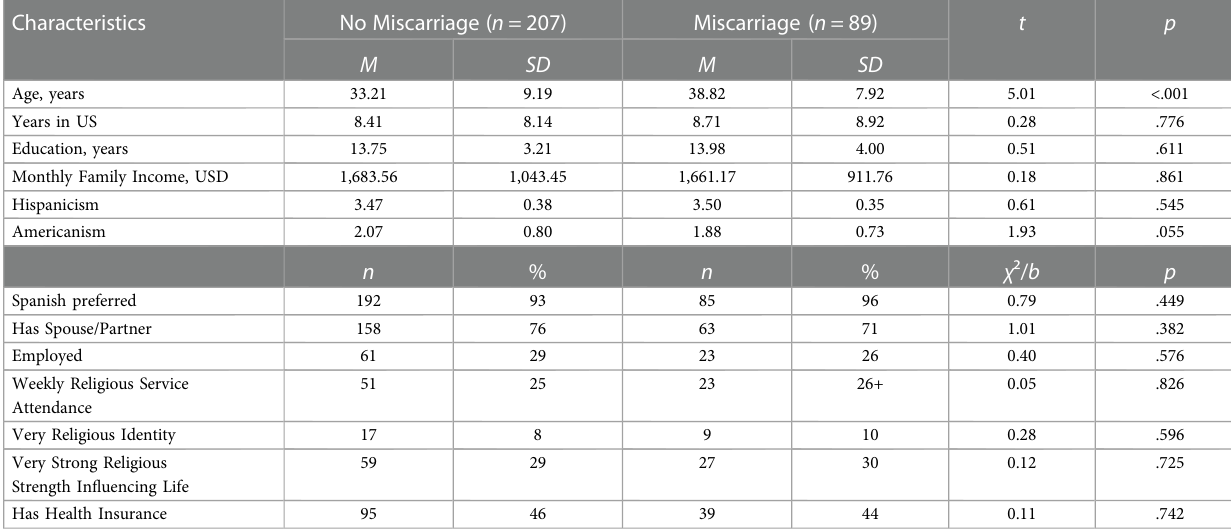
TABLE 2 Sociodemographic Characteristics of Latinas with a History of Miscarriage. Characteristics